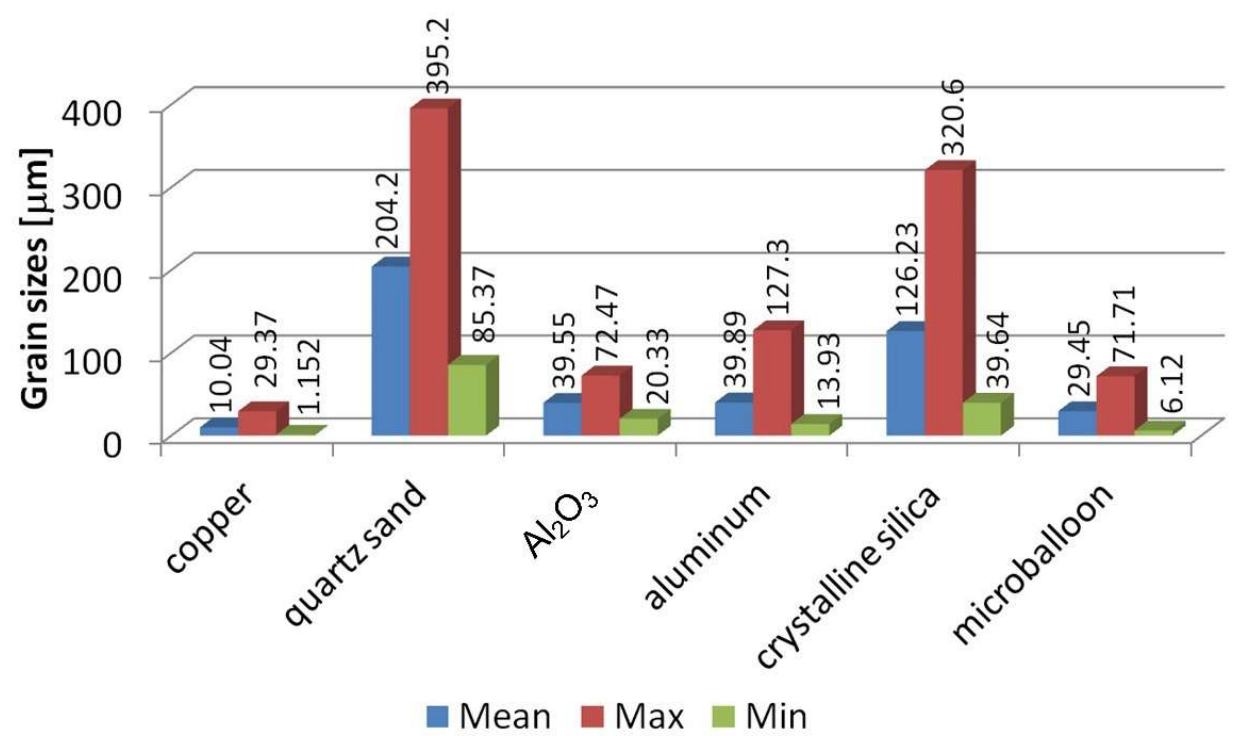
Figure 2. Grain sizes ( m).